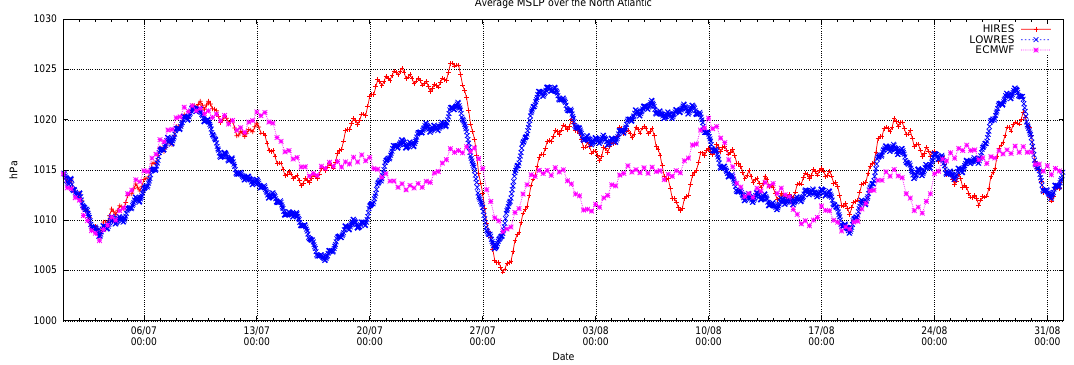
Figure 10. Time series of the MSLP averaged between 40 and 65 ◦ N, and 60 ◦ W and 10 ◦ E.